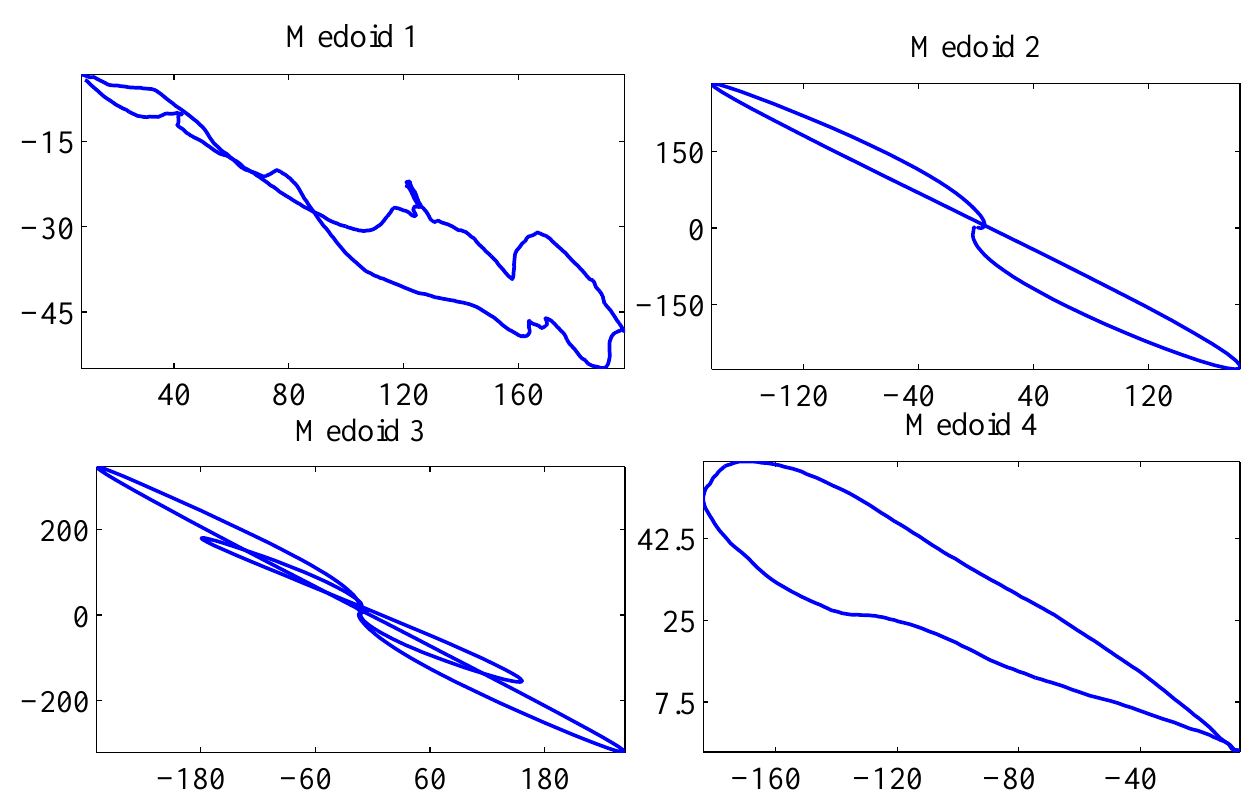
Figure 6. Resultant medoids represented in the complex impedance plane.